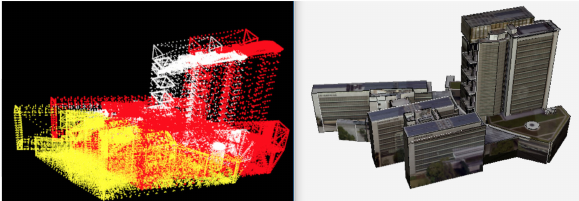
Figure 15. Automatic matching of 3D model changes to